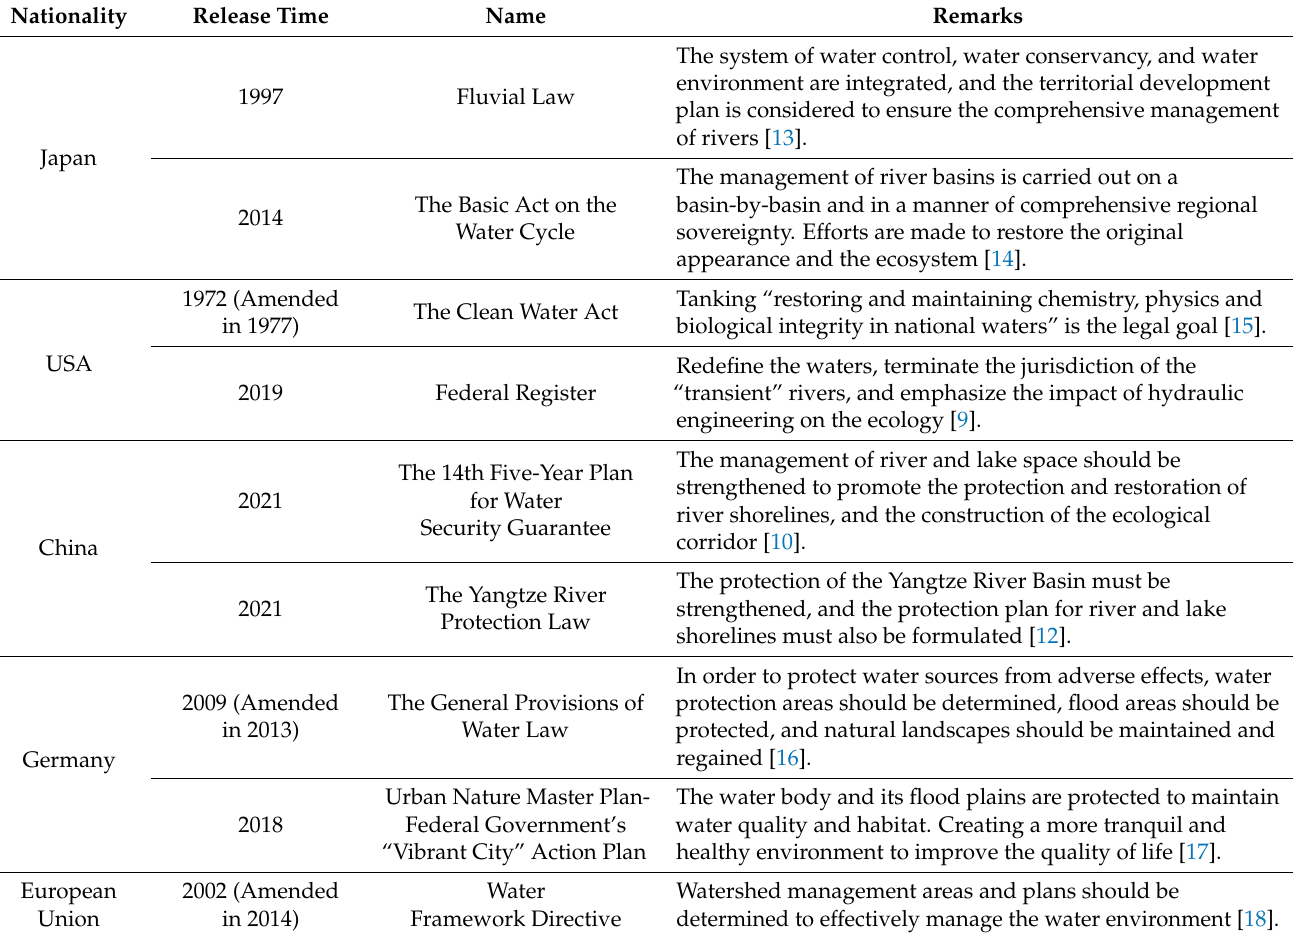
Table 1. Relevant laws and regulations for river ecological protection at home and